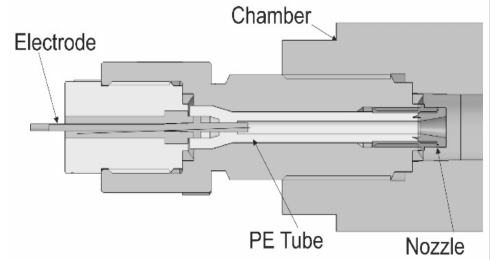
Figure 2. Ignition plug equipped with plasma generator (cross